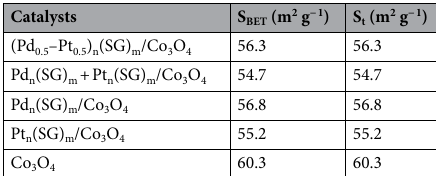
Table 2. Specific surface area data for the prepared catalysts and pure support .